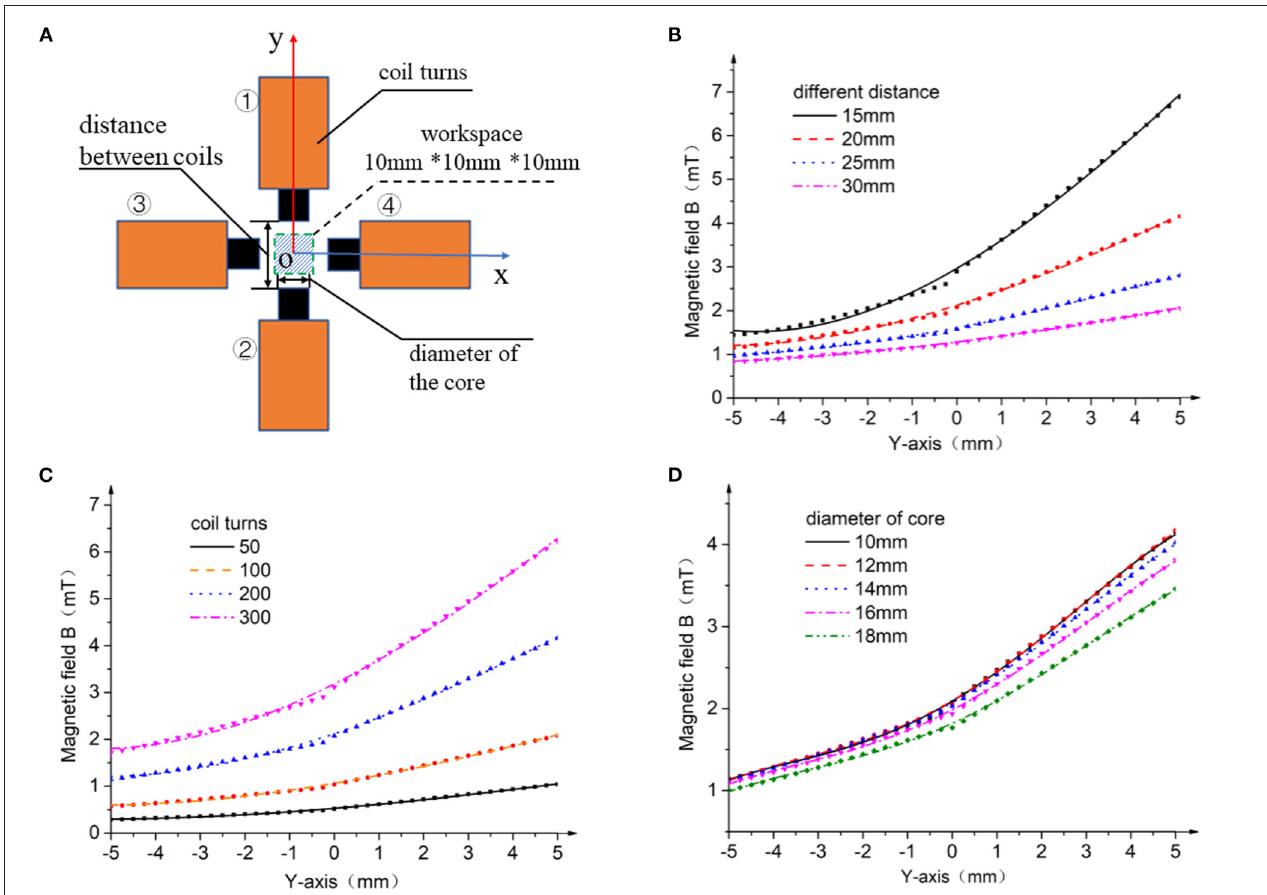
FIGURE 2 | Parameter optimization of the electromagnetic system. (A) Parameterized model; (B) magnetic field distribution with different distance between coils; (C) magnetic field distribution with different coil turns; (D) magnetic field distribution with different diameters of iron